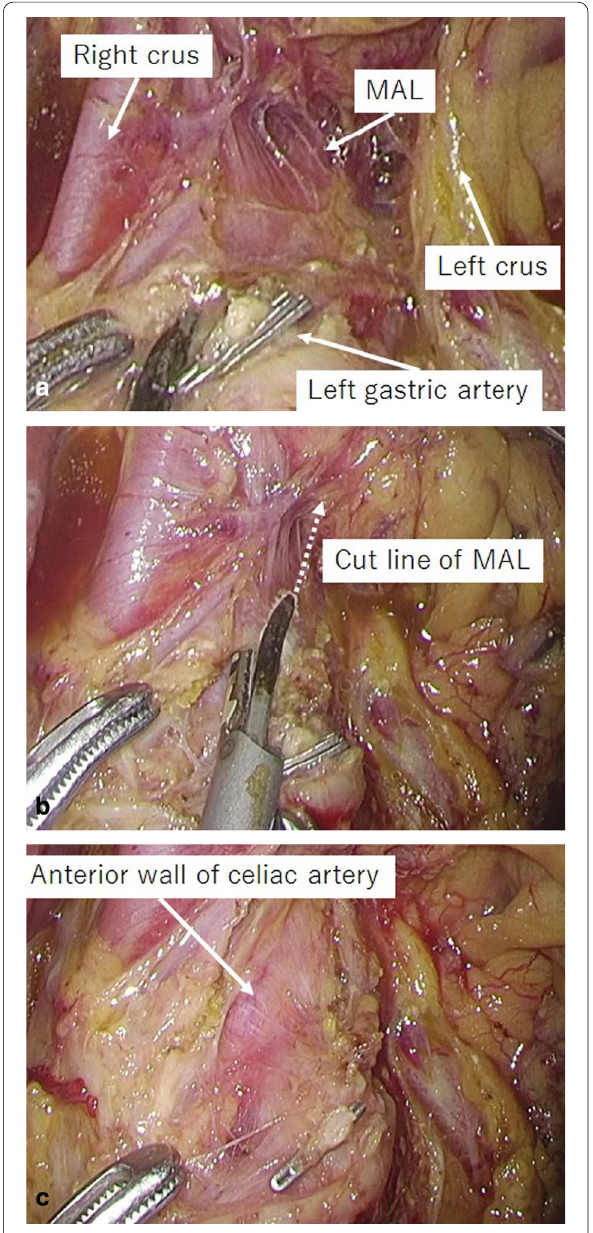
Fig. 3 a The median arcuate ligament (MAL) was found on the ventral side of the left gastric artery stump. b An ultrasonic coagulation cutting device was used to release the MAL. c The anterior wall of the celiac artery was exposed